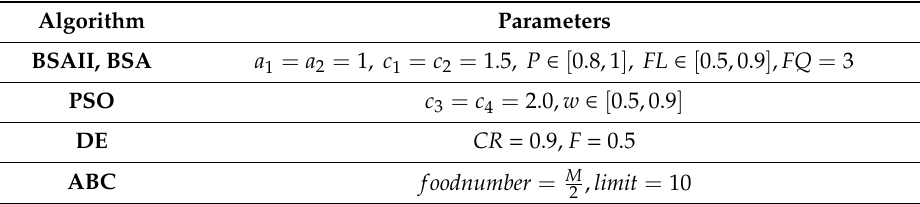
Table 5. Parameter